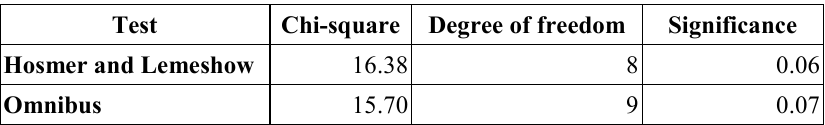
Table 4. Hosmer and Lemeshow Goodness Test and Omnibus Test for the Disciplinary Penalty Status Test Chi-square